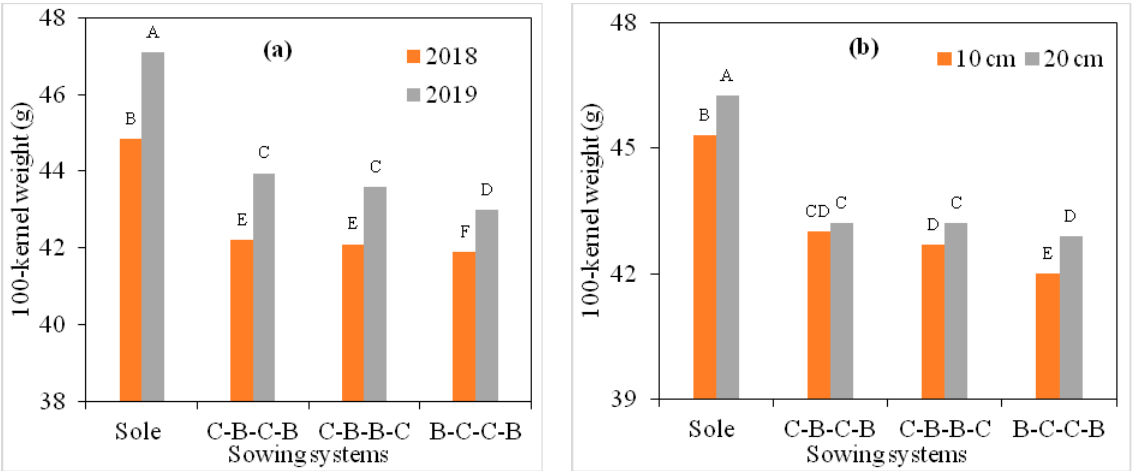
Figure 10. The interactions of maize-white bean sowing systems on 100-kernel weight ( a , b ) at Nur Sultan, Kazakhstan research station. Letters on each bar represent significance level at p < 0.05 and p < 0.01. Note: different letters denote significant differences, while the same letters indicate insignificantly different values.